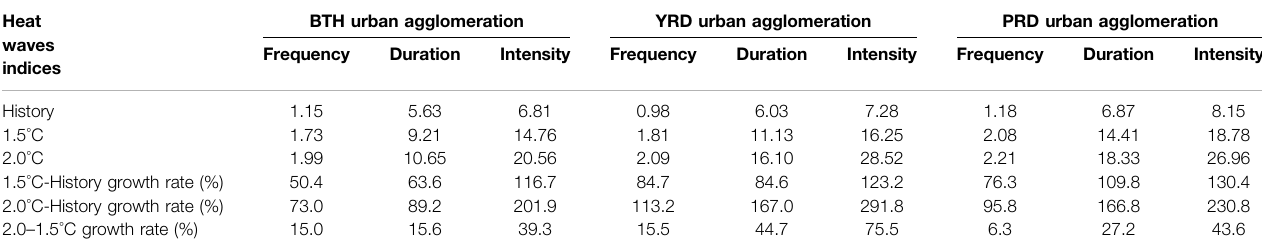
TABLE 1 | The values and growth rates of the three HW indices in the three urban agglomerations over eastern China under historical and different warming scenarios. Heat waves